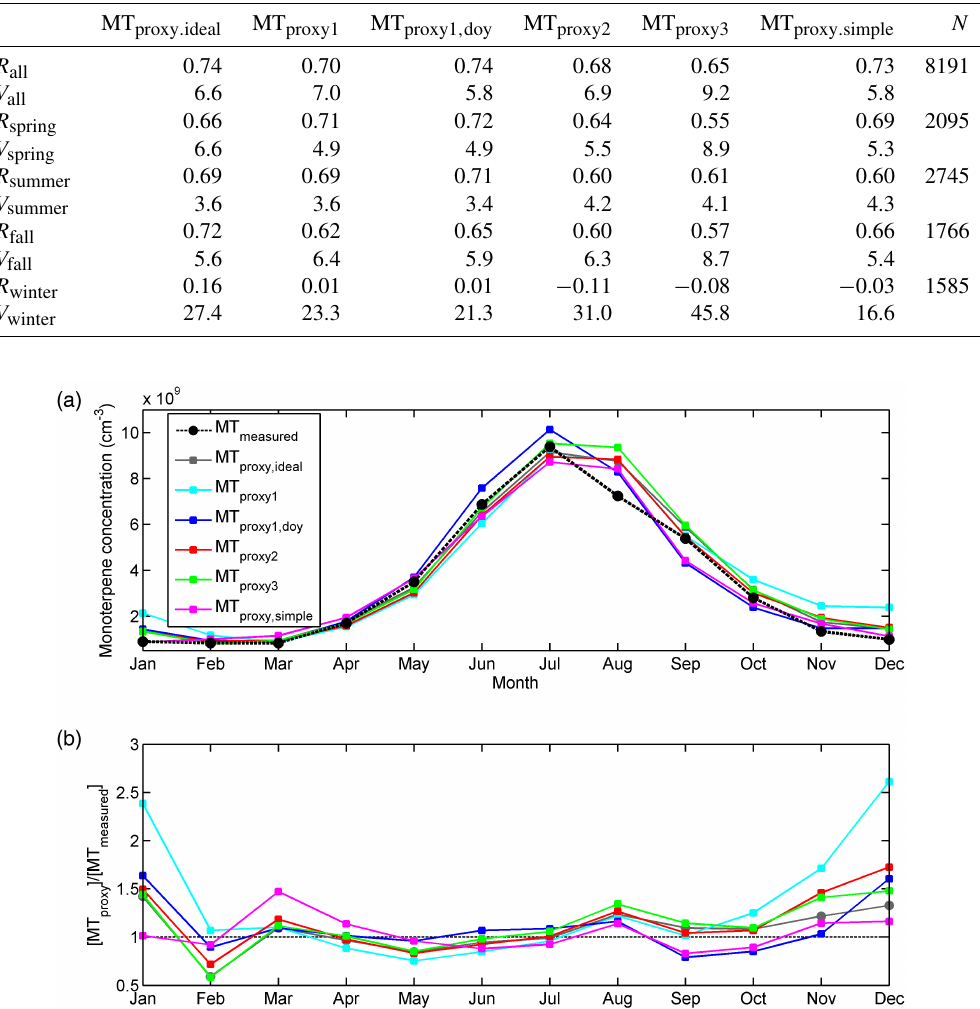
Figure 6. Monthly medians of (a) the concentrations of the measured monoterpenes and different proxies and (b) the ratios of different proxies to measured monoterpene concentration. The black circles show the measured concentration, the gray squares show MT proxy , ideal , the light blue squares MT proxy1 , the dark blue squares MT proxy1 , doy , the red squares MT proxy2 , the green squares MT proxy3 and the magenta squares MT proxy , simple